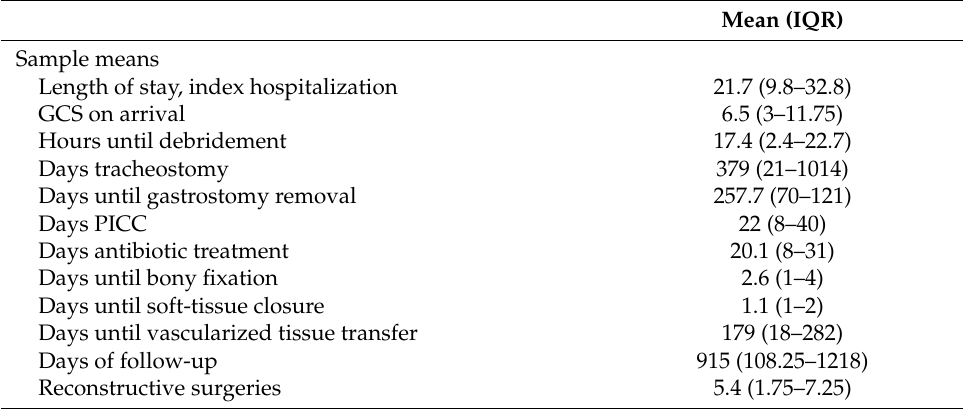
Table 4. Management and reconstruction of patient cohort (N =